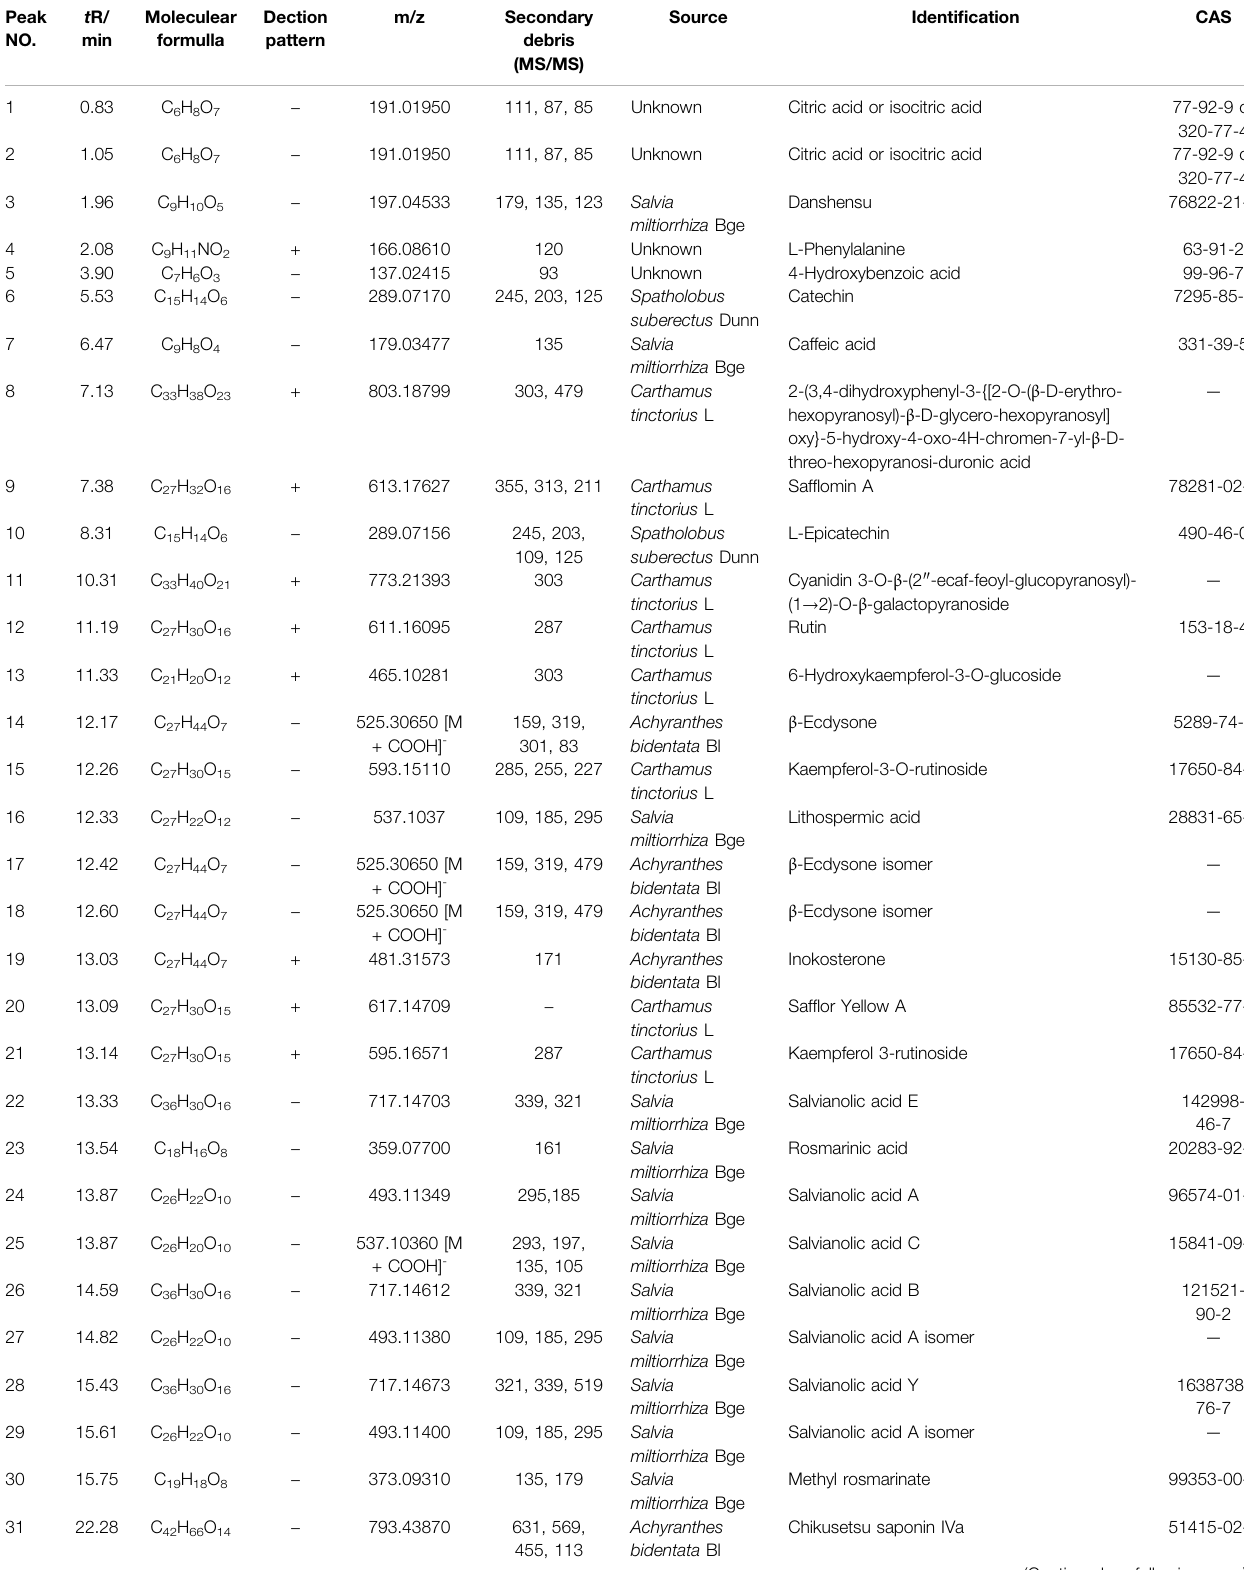
TABLE 2 | Components identi fi ed in TLYS decoction. Peak